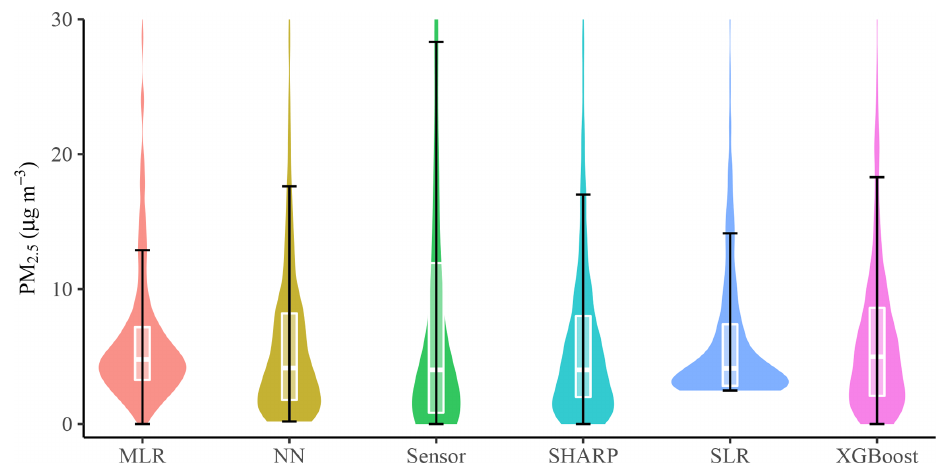
Figure 8. Data density comparison in the test dataset. Based on 610 test examples. NN: neural network, MLR: multiple linear regression, SLR: simple linear regression. PM 2 . 5 data greater than 30µgm − 3 are not shown in the figure. See the box plot explanation in Fig.